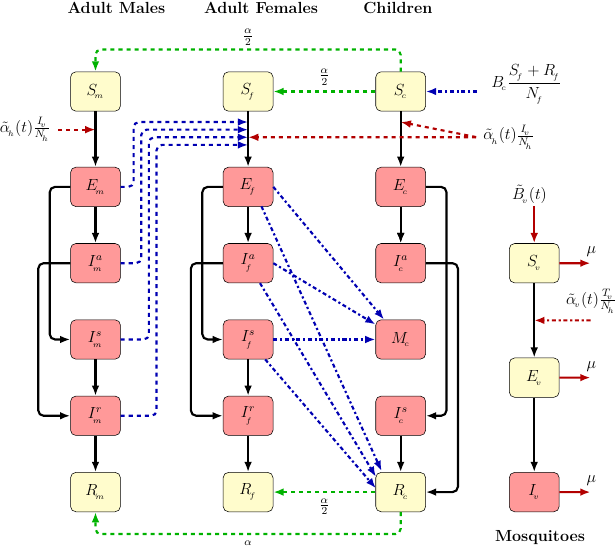
Figure 1. The dynamics of the spread of the Zika virus, taking into account three human groups, and sexual, vertical and vectorial transmission. Adult males, adult females, children and mosquitoes are denoted by the lower indices m , f , c and v , respectively. Yellow nodes denote non-infectious and red nodes denote infectious compartments. The disease progression is depicted by black, solid arrows. The direction of sexual transmission from adult males to adult females is shown by blue dashed arrows, while blue dash–dotted arrows illustrate the direction of vertical infection from adult females to their children. Green dashed arrows show the direction of the maturation from child to adult. Red dashed lines show the direction of mosquito-to-human